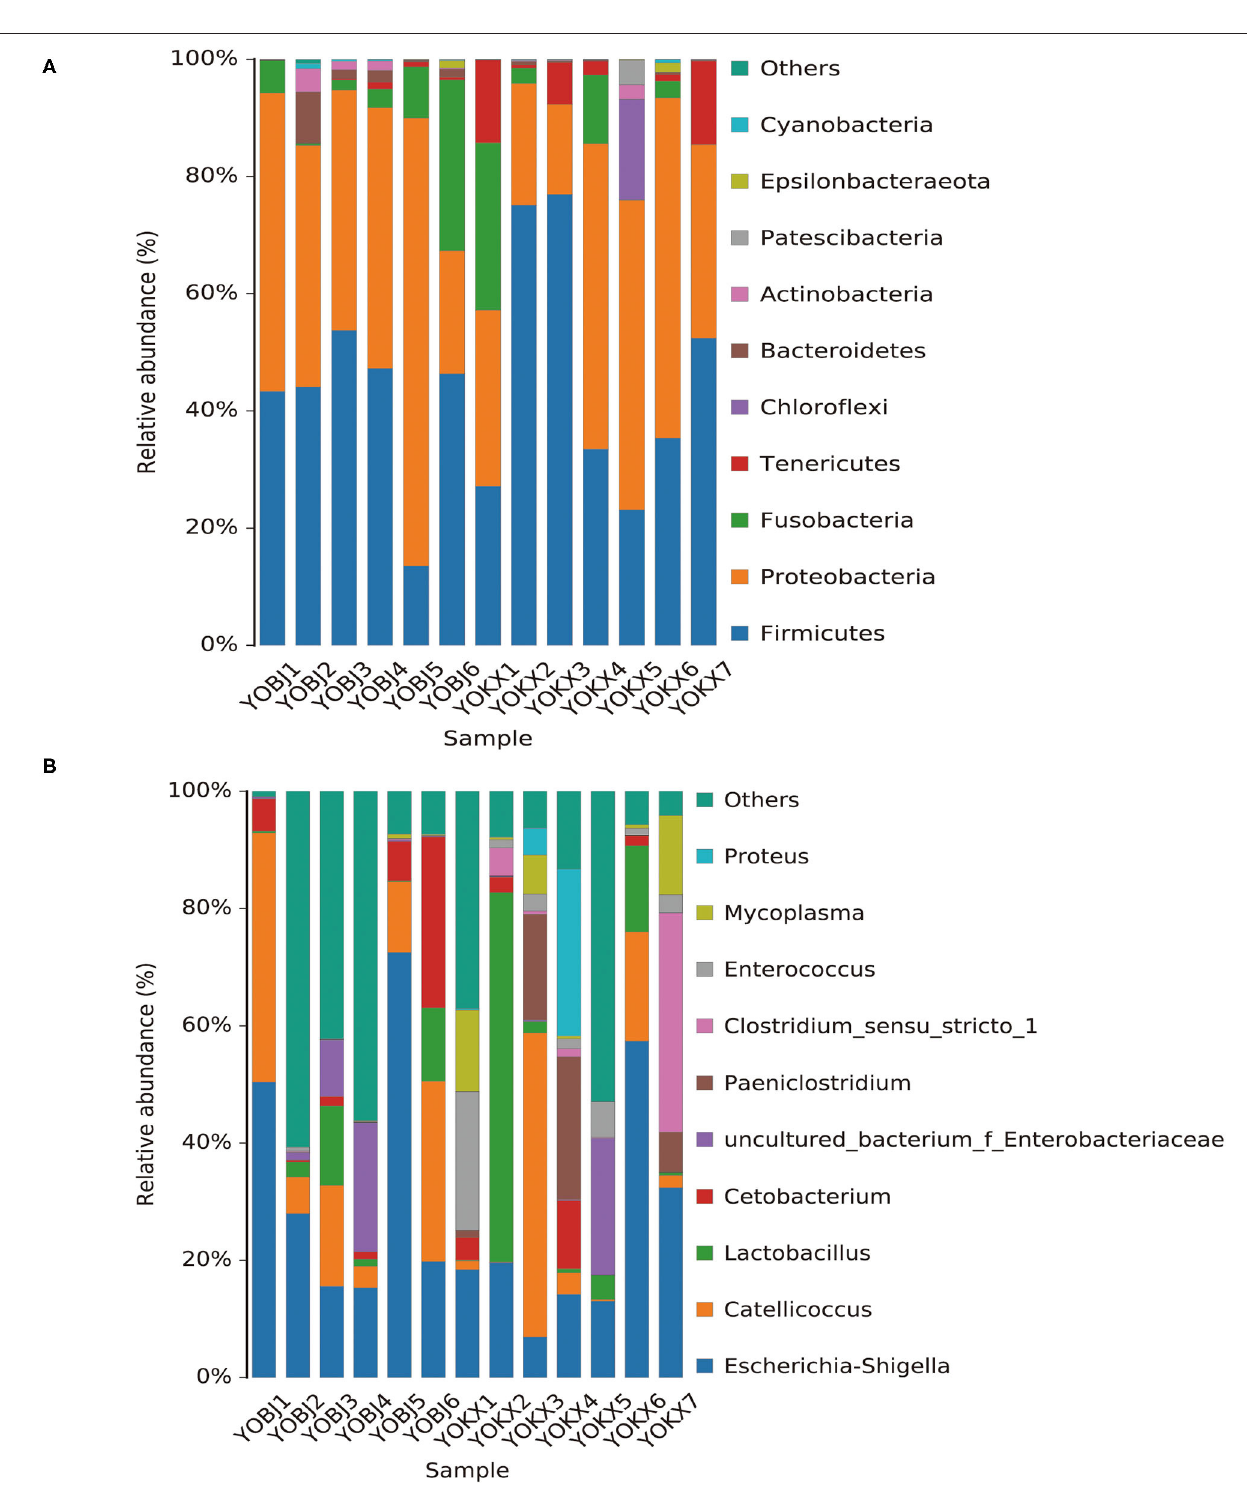
Frontiers in Veterinary Science |